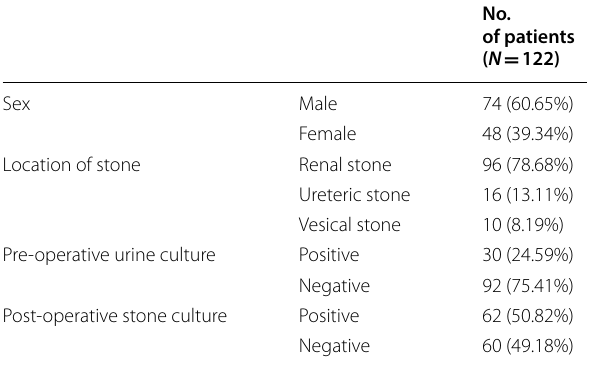
Table 2 Culture results